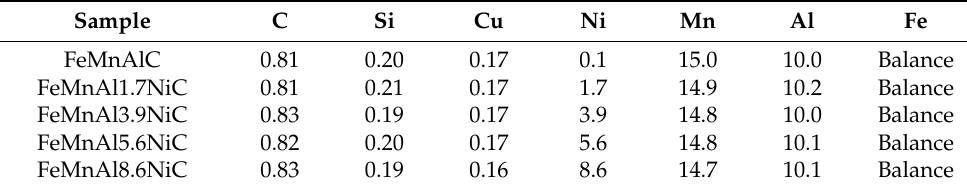
Table 1. Chemical composition of samples is expressed in percent by